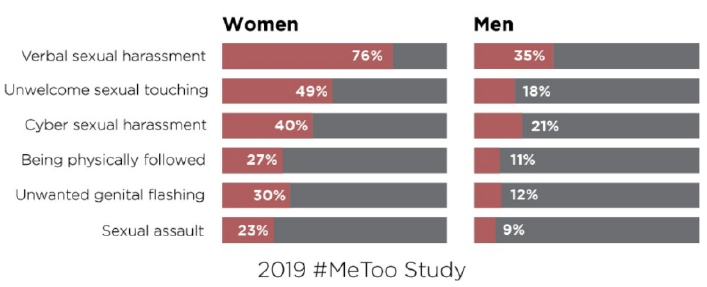
Figure 1. National prevalence of sexual harassment and assault [2].